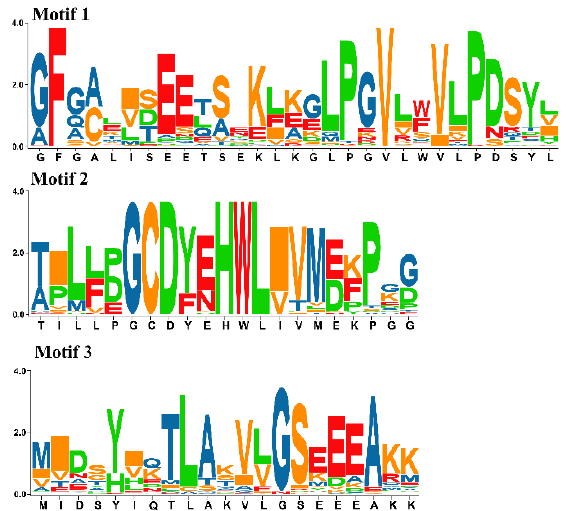
Figure 1. Seqlogo of conserved motifs in kiwifruit MORF genes. Protein sequences were used to estimate amino acids’ residue variation. The bit score represents the information content for each position in the sequence.